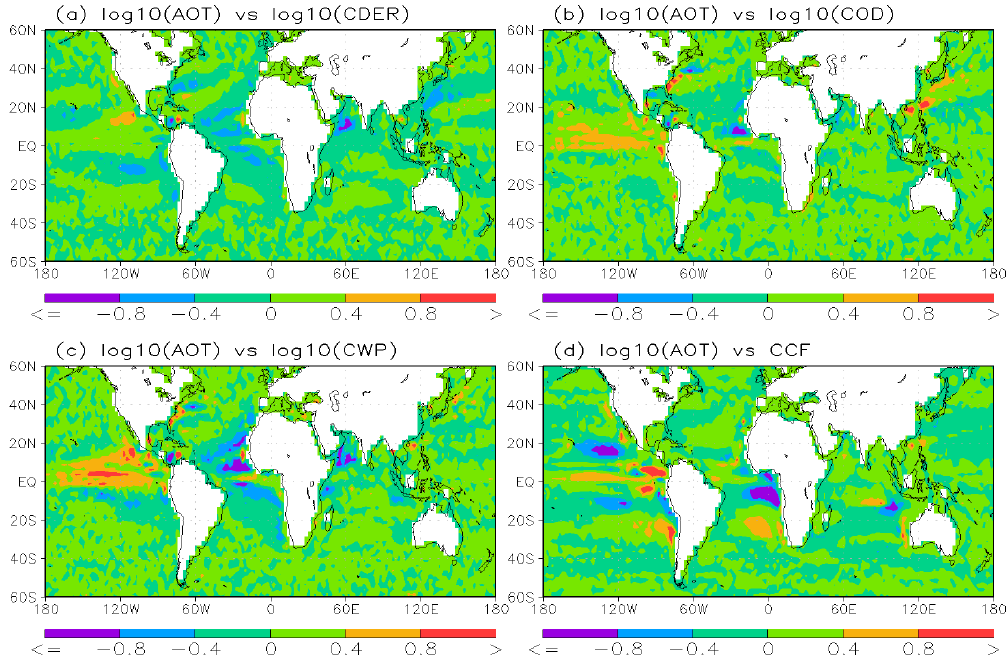
Figure 5. Global distributions of the linear correlation slope between: ( a ) log 10 ( AOT ) and log 10 ( CDER ); ( b ) log 10 ( AOT ) and log 10 ( COD ); ( c ) log 10 ( AOT ) and log 10 ( CWP ); and ( d ) log 10 ( AOT ) and CCF . The linear correlation is calculated for 2.5° × 2.5° spatial grids over global oceans using the long-term averaged monthly mean values in 0.1° × 0.1° spatial resolution.